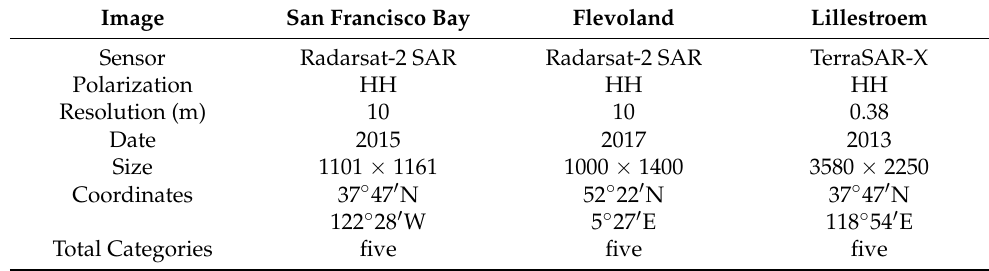
Table 1. Geographic information of real